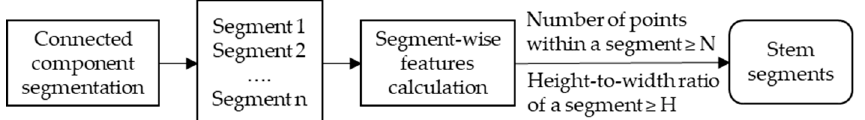
Figure 5. Overview of the step of segment-based stem point identification. N refers to the threshold of the number of points, and H refers to the threshold of height-to-width ratio.